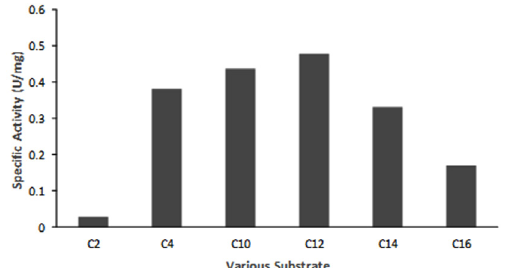
Fig. 5. Activity of 0-20 % fraction toward different length of carbon range. (1) p-NP acetate (C2); (2) p-NP butyrate (C4); (3) p-NP caprate (C10); (4) p-NP laurate (C12); (5) p-NP myristate (C14); (6) p-NP palmitate. Maximum activity was showed on p-NP laurate